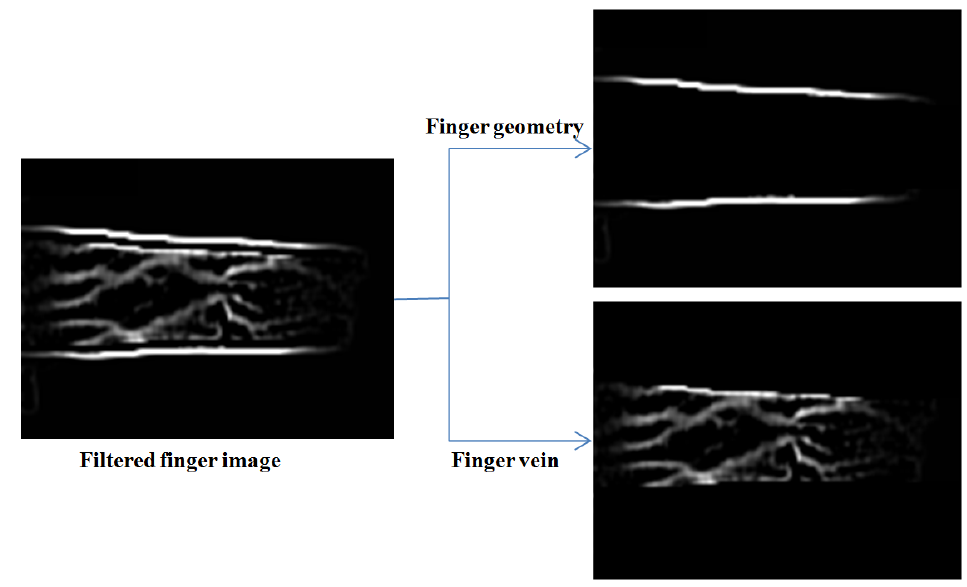
Figure 11. An example of manually separating filtered finger image into two component images such as finger geometry and finger vein.